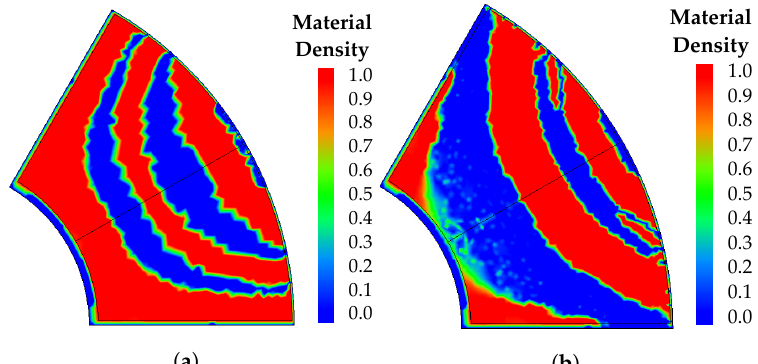
Figure 10. Results of torque ripple optimization, and material density of ( a ) 2 mm mesh model and ( b ) 1 mm mesh